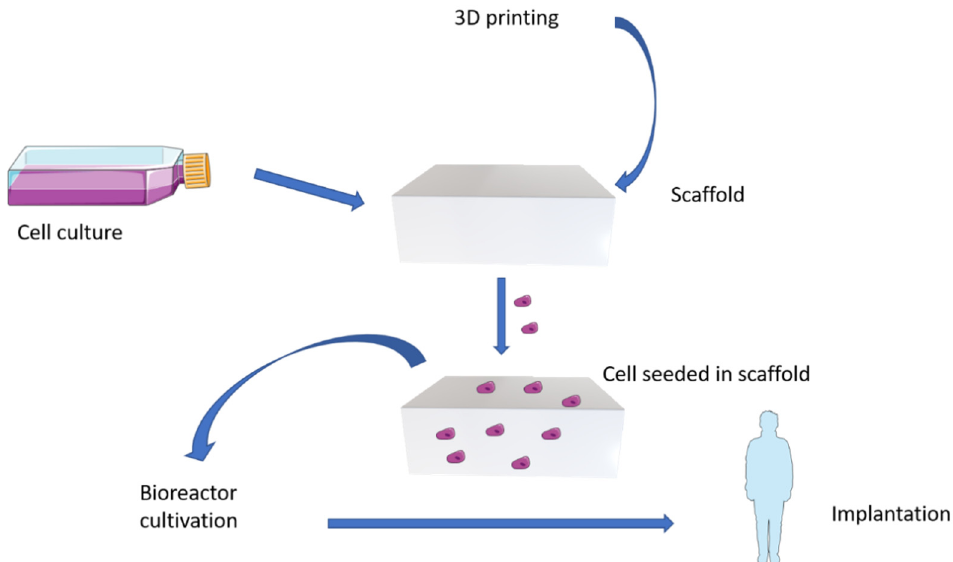
Figure 4. Bioscaffolds are 3D printed with biocompatible materials which generate 3D patterns. This process allows to incorporate the cells which have grown under specific conditions in culture. Afterwards, the scaffold goes to the bioreactor so that it can be implanted. Based on [30]. (Adapted and modified from Servier Medical Art. Servier is licensed under a Creative Commons Attribution 3.0 Unported License).